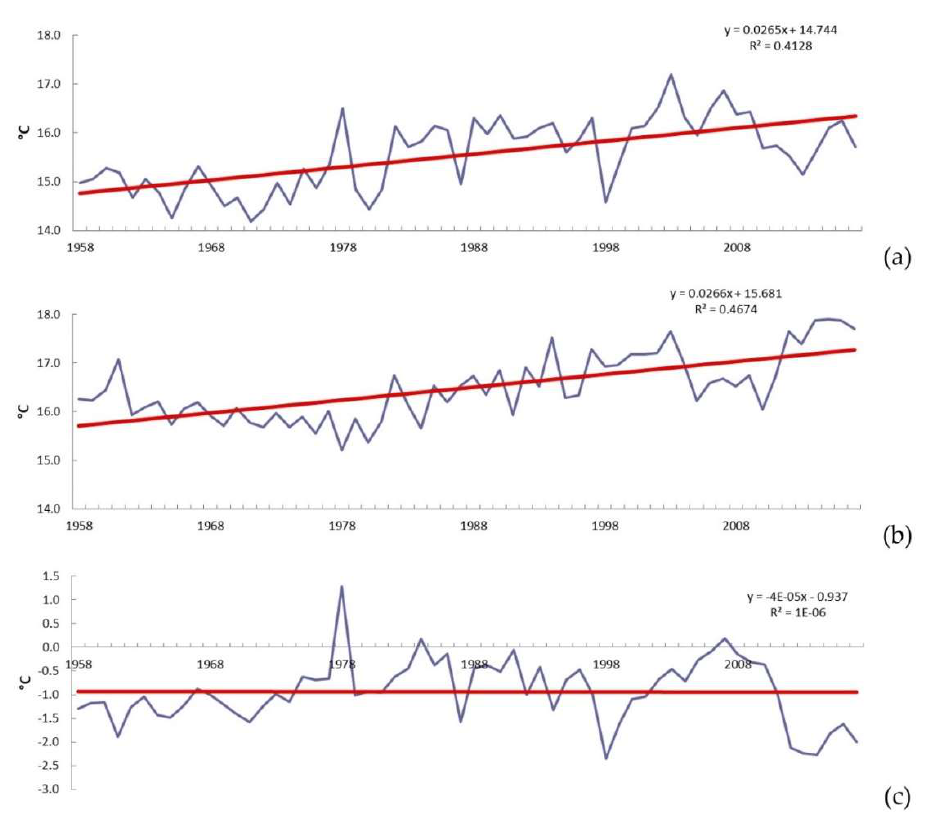
Figure 4. Trend over time in air temperature, Casalotti ( a ) and Collegio Romano ( b ), and absolute difference between Casalotti and Collegio Romano by year ( c ), 1958-2017.